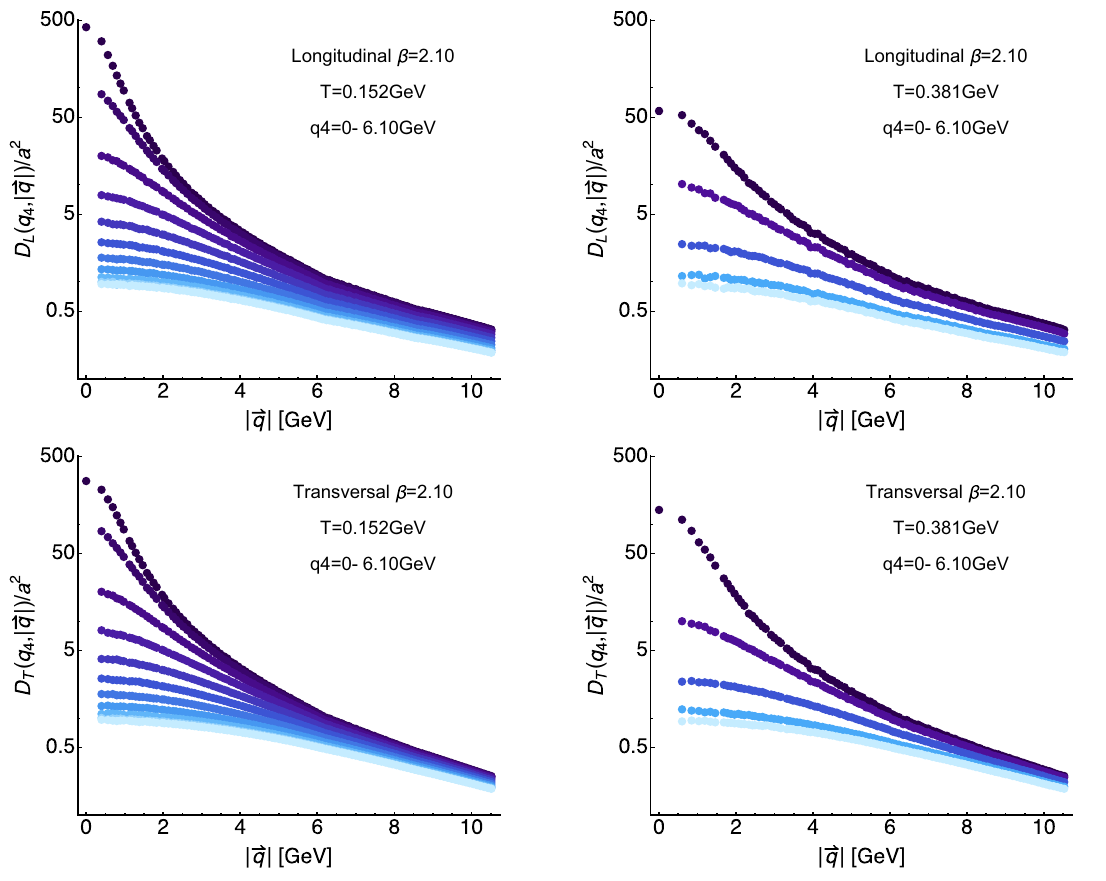
for the lowest T = 0 . 152 GeV (left) and a high T = 0 . 381 GeV (right). The color coding assigns darkest colors to the lowest value of q